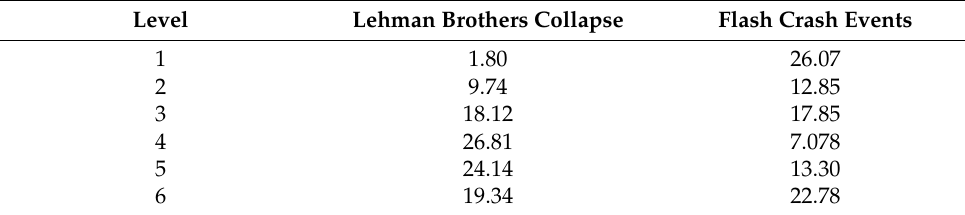
Table 7. Power spectra for MCD stock market